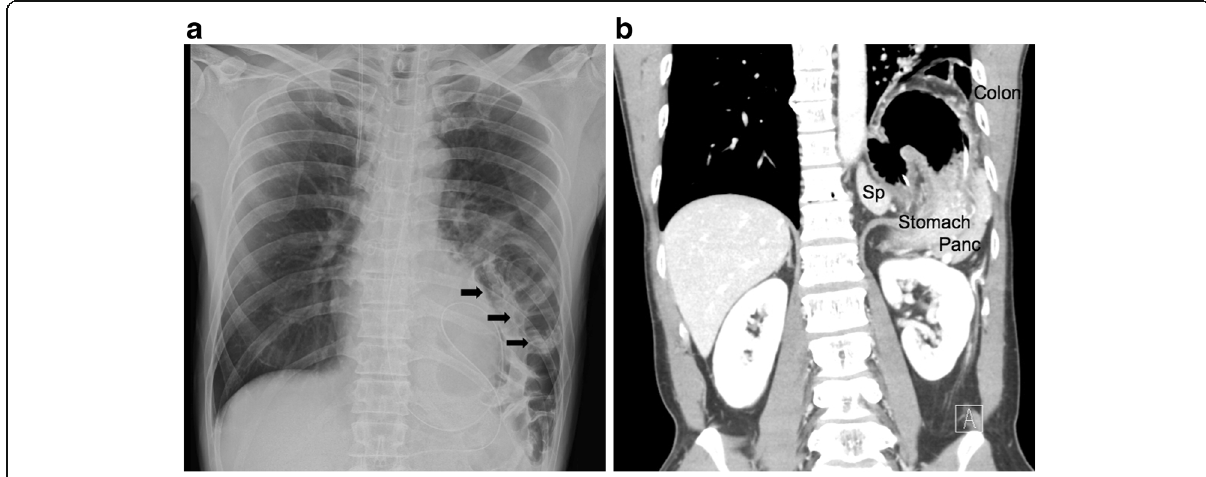
Fig. 1 Chest X-ray showing colon gas and a nasogastric tube above the left diaphragm. Arrows showed the herniated colon ( a ). Coronal CT imaging revealed herniation of the stomach, pancreas, spleen, and colon ( b )